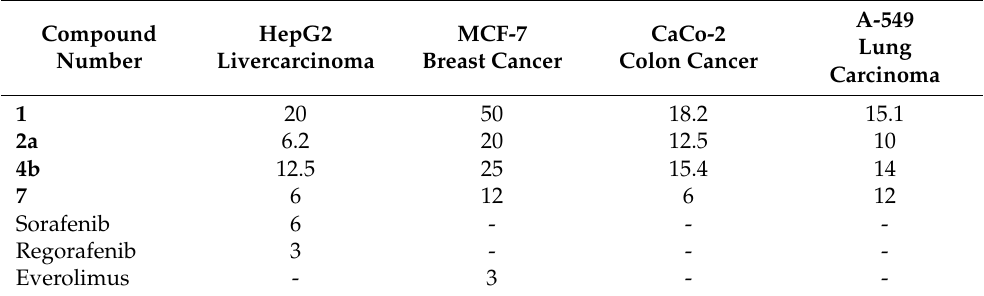
Table 2. In vitro cytotoxic (IC50 values ( µ M)) effects of the novel compounds in A-549, CaCo-2, MCF-7 and HepG2 cell lines.